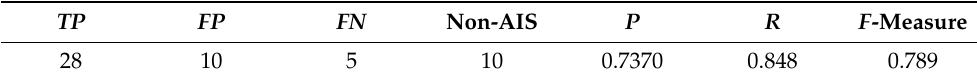
Table 2. Detection results using the test images confirmed by AIS data. TP and FP are the numbers of correctly detected moving ships and misdetected ships, respectively. FN is the number of moving ships but not detected, and non-AIS is that of detected ships without AIS